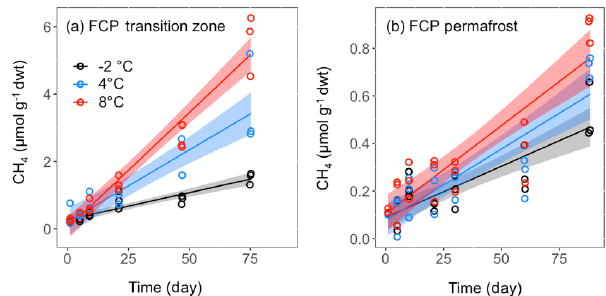
Figure 3. CH 4 production in soil microcosms from (a) transition layer, and (b) permafrost layers of FCP at indicated temperatures. The temporal profiles of CH 4 production were best fitted with the linear regression model, and the shaded area represents the 95% confidence